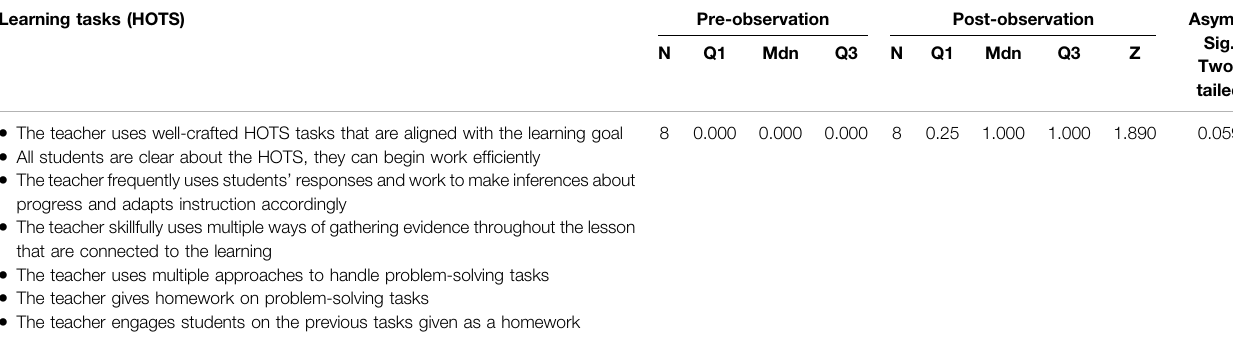
TABLE 5 | Rating results for using learning tasks within FAHOTS as observed by the researcher during pre- and post-observations. Learning tasks